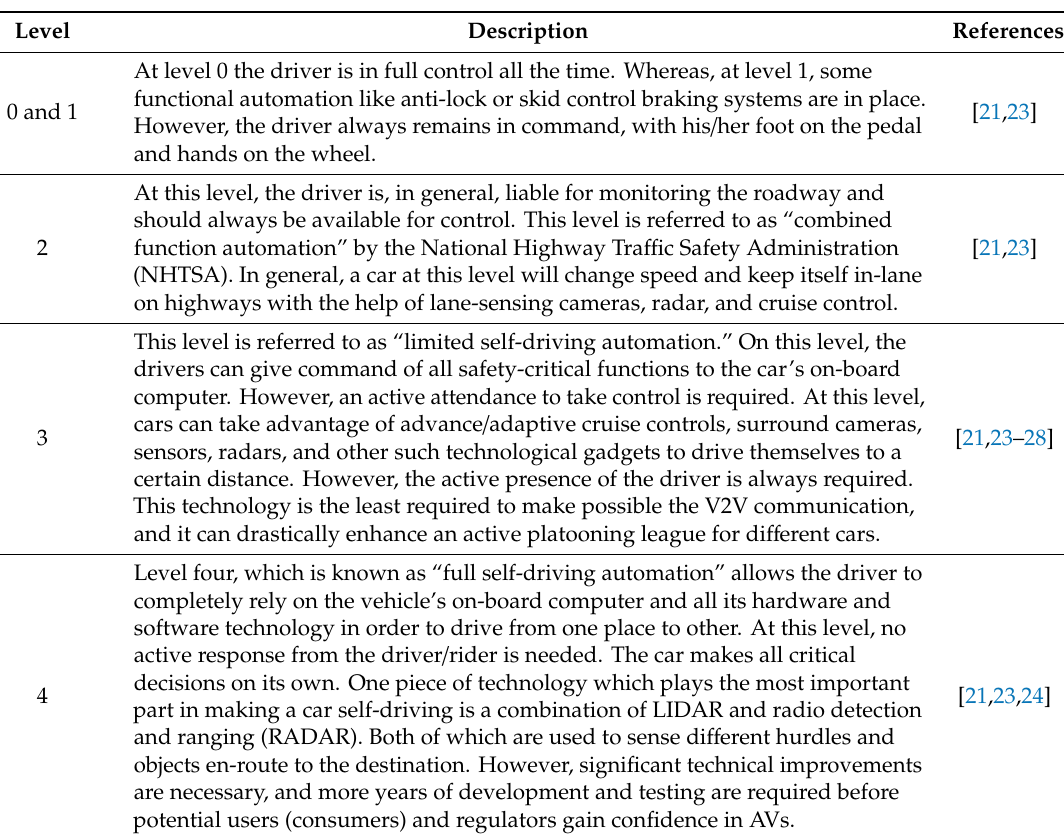
Table 2. Levels of automation.